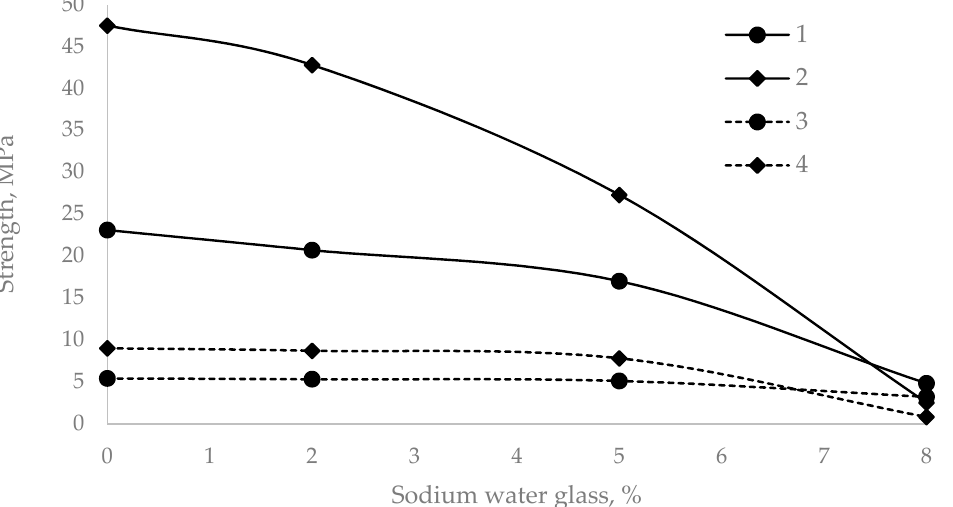
Figure 2. Compressive and flexural strength of cement mortars with different sodium water glass dosages. (1 and 2—compressive strength after 2 and 28 days; 3 and 4—flexural strength after 2 and 28 days.).